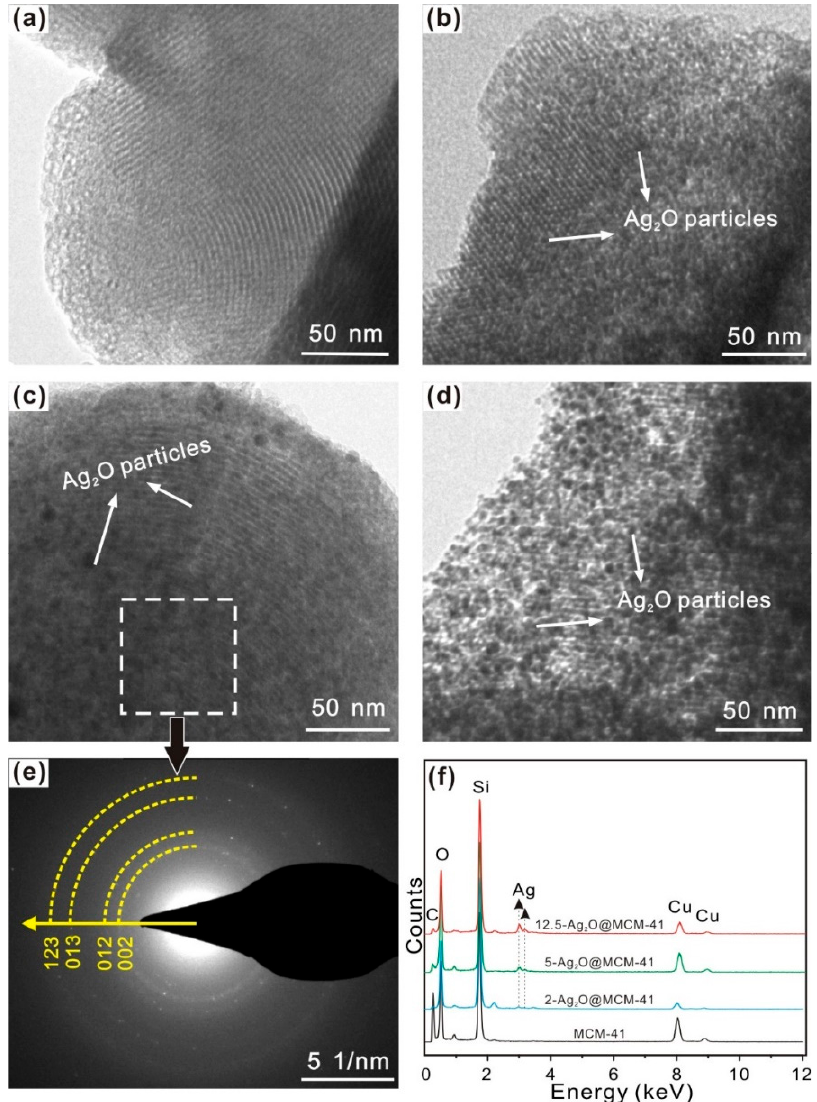
Figure 2. TEM images of ( a ) MCM-41, ( b ) 2-Ag 2 O@MCM-41, ( c ) 5-Ag 2 O@MCM-41, and ( d ) 12.5- Ag 2 O@MCM-41. ( e ) SAED pattern of the dashed area in ( c ), and ( f ) the EDS spectra of the prepared nanomaterials. All the spectra were normalized by peak intensities of Si element. Table 1. The Ag 2 O contents and the textural parameters of different samples.